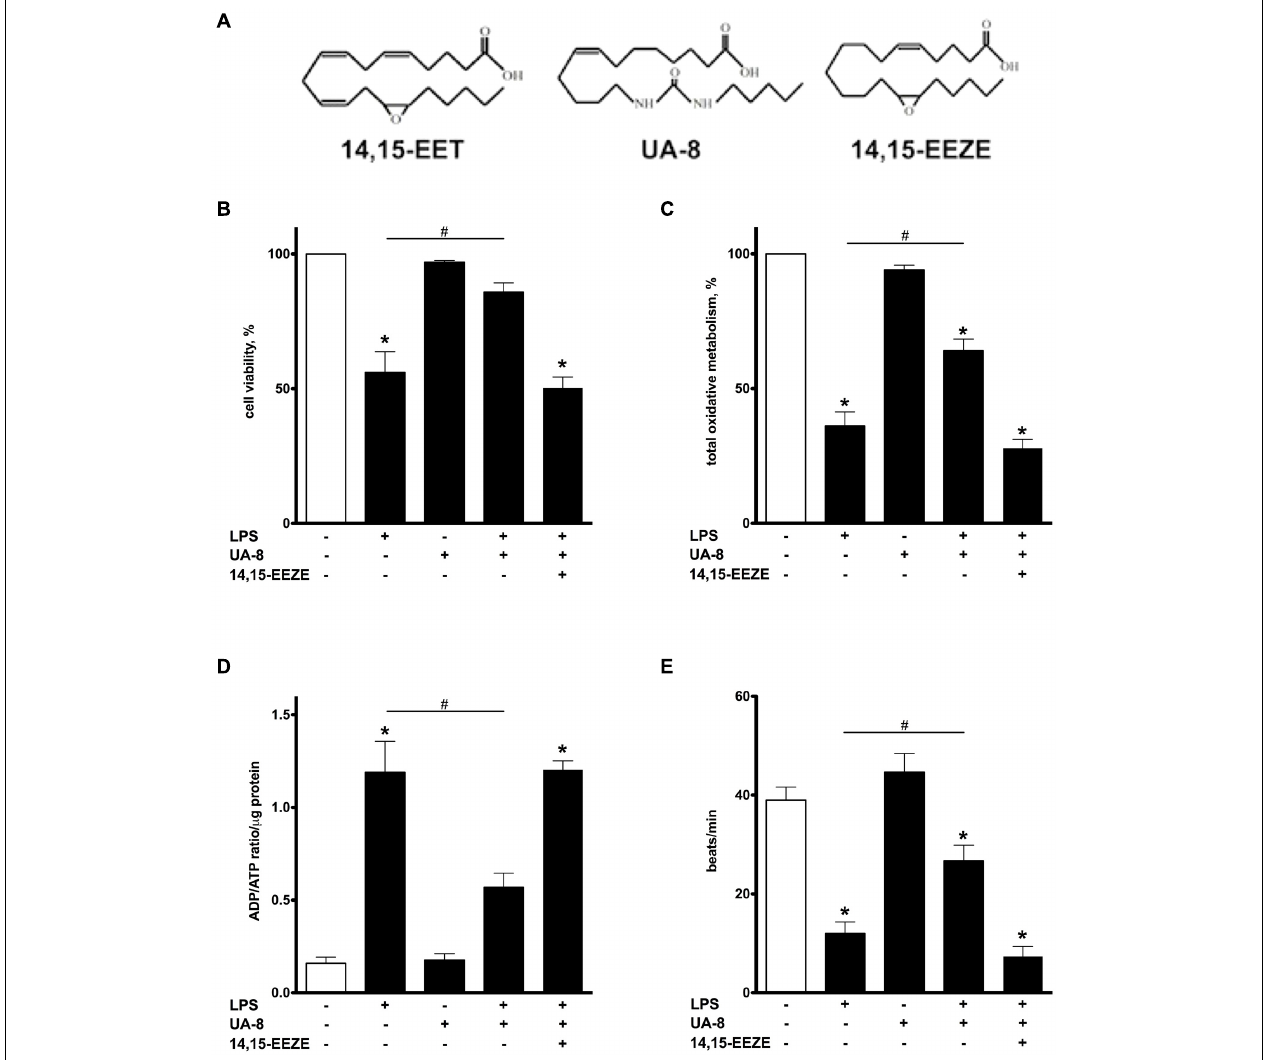
metabolic activity was preserved by treatment with UA-8. (D) UA-8 prevented LPS-induced increase in ADP/ATP ratio. (E) UA-8 attenuated LPS-impaired contractility of NCMs. Values are represented as mean ± SEM, N = 3–4. Significance was set at P < 0.05. * Significantly different from control. # Significantly different from LPS-treated